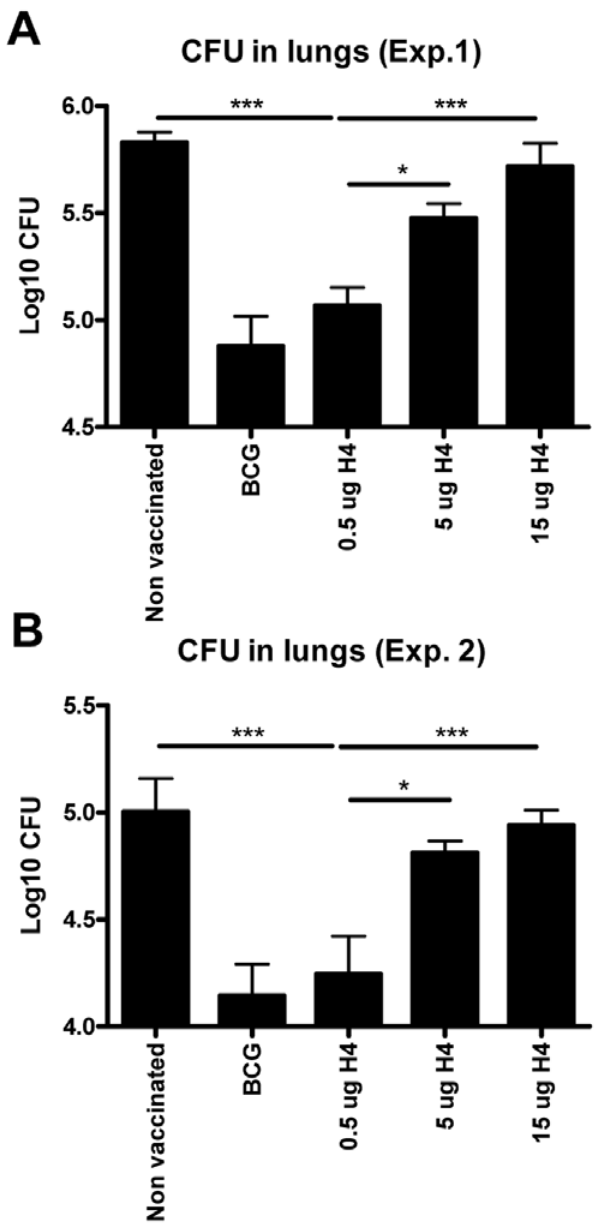
Figure 4. Protective efficacy of different doses of Ag85B- TB10.4 in IC31 H . In two independent experiments (A and B) groups of mice were vaccinated with three different doses of H4 formulated in IC31 H and compared to saline and BCG vaccinated controls. All groups were challenged by the aerosol route with virulent M.tb ten weeks after the first vaccination. Six weeks post-challenge, all mice were killed and the bacterial burden (CFU) was measured in the lung. In both experiments data are presented as mean values from six animals per group and standard errors of the means are indicated by bars. Statistical comparison among the vaccination groups were done by one-way ANOVA and Tukey’s post test. Significant differences are shown. ***: p , 0.001, *: p ,